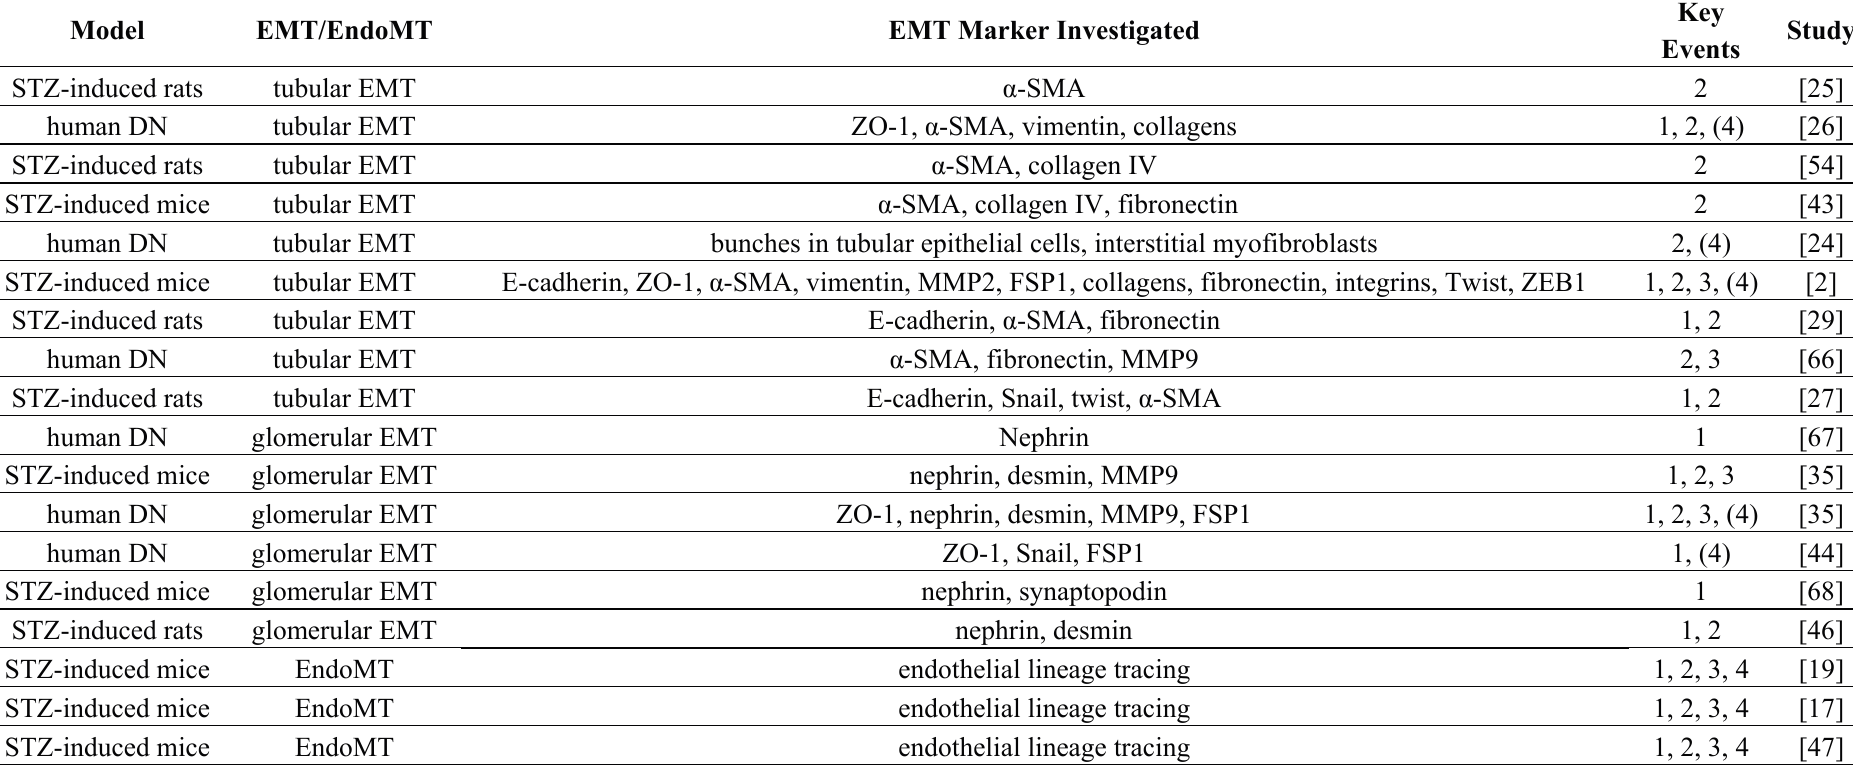
Table 2. Overview of the experimental design of the major studies that demonstrated evidence for tubular and glomerular EMT and EndoMT in vivo. Model